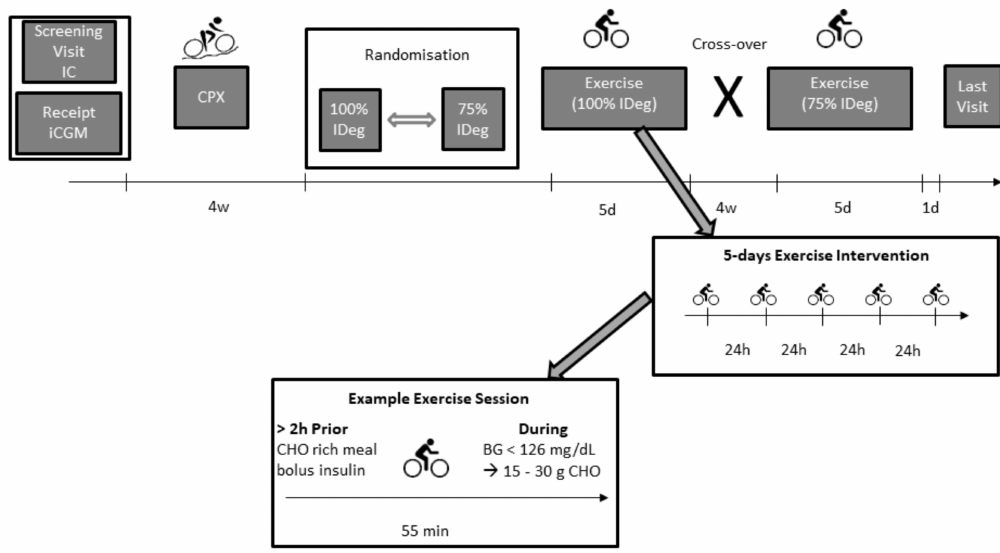
Figure 1. Study flow chart. IC = informed consent procedure, iCGM = intermittently-viewed continuous glucose monitoring system, CPX = peak cardio-pulmonary exercise test, IDeg = insulin Degludec, CHO = carbohydrates, BG = blood